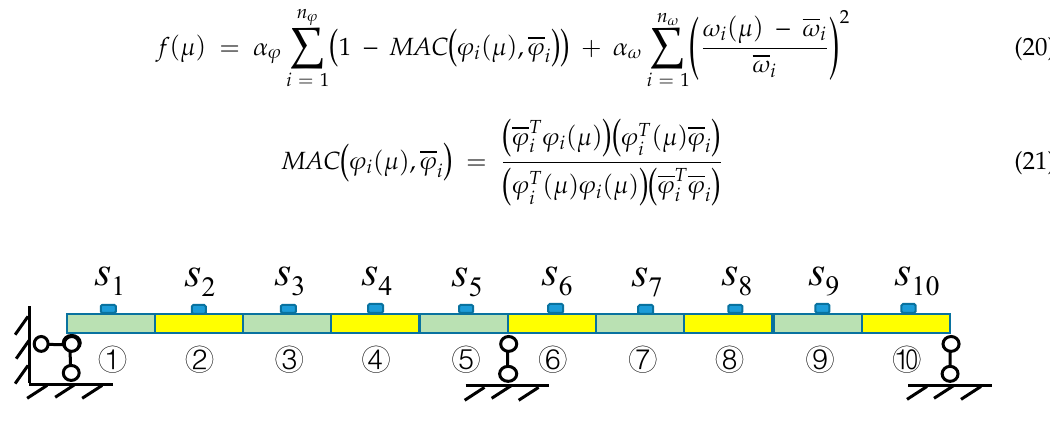
Figure 28. Location of the acceleration sensors.